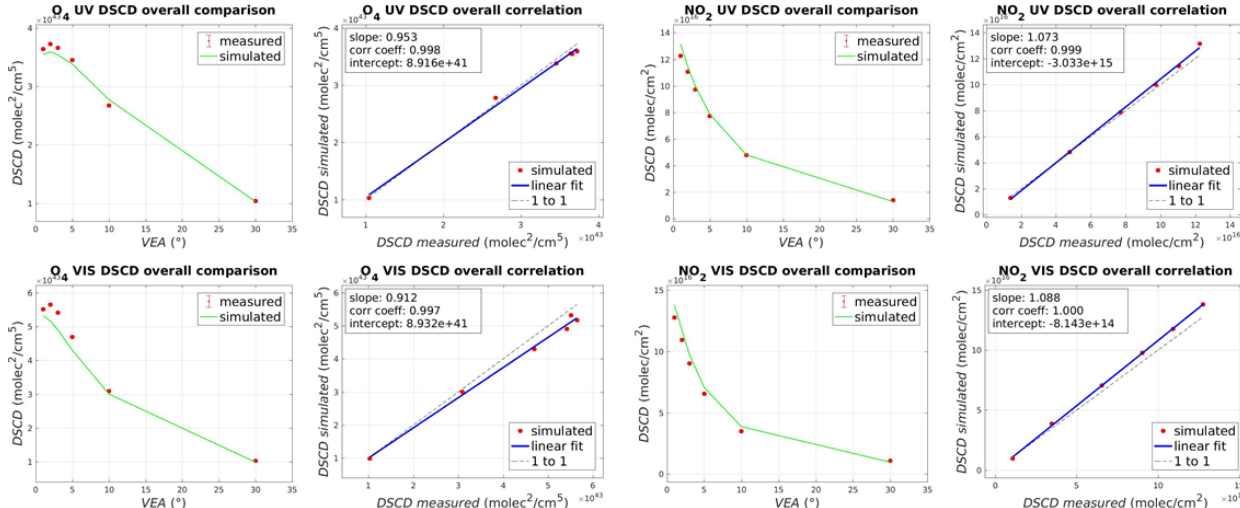
Figure 6. Comparison between simulated and measured DSCDs of O 4 and NO 2 . Red dots represent the measured DSCDs for each VEA averaged over the entire campaign.